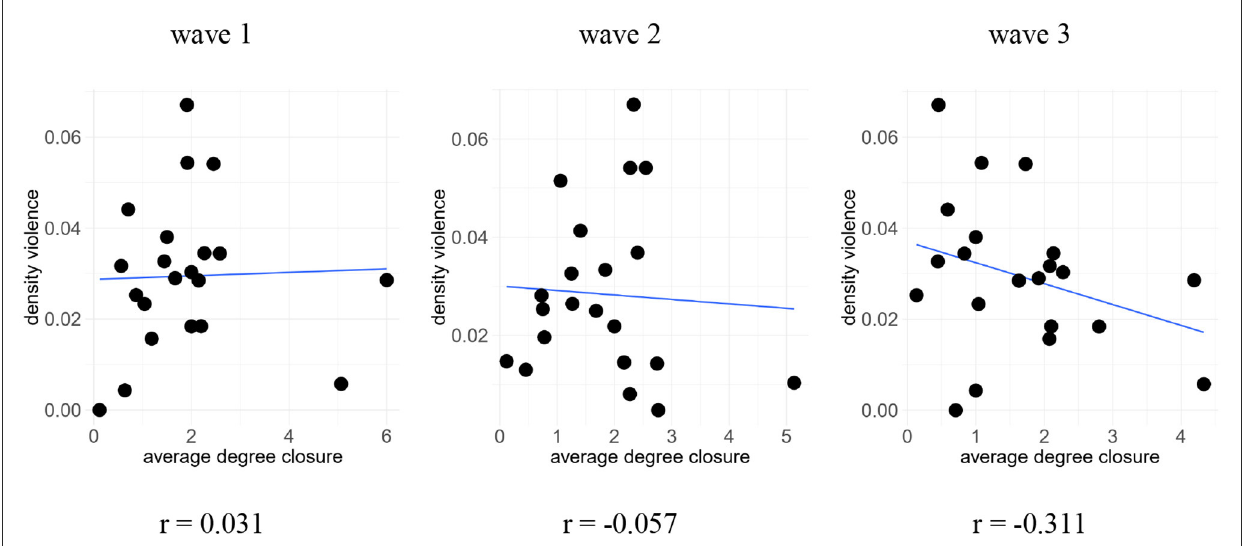
FIGURE4 Correlation of global network characteristics: “Average indegree closure” and “school violence density,” N = 501 students; k = 21 classes. Source: Own